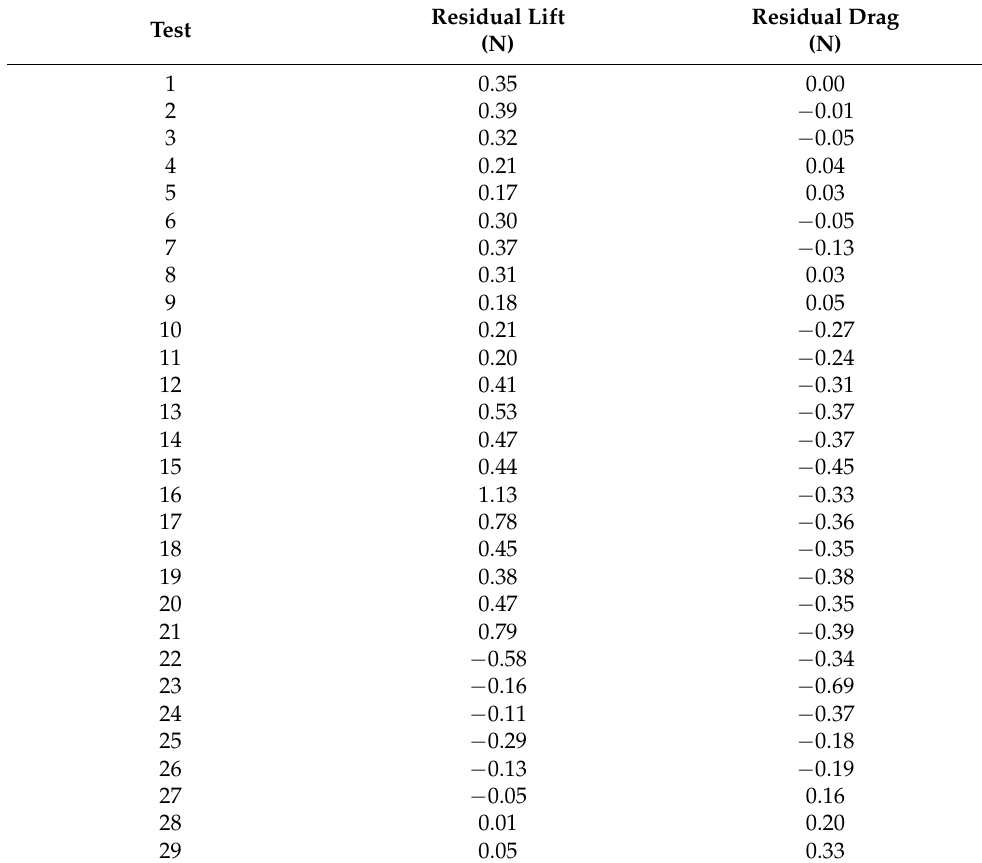
Table 10. Residual values of the experimental and simulated lift and drag forces. Residual Test